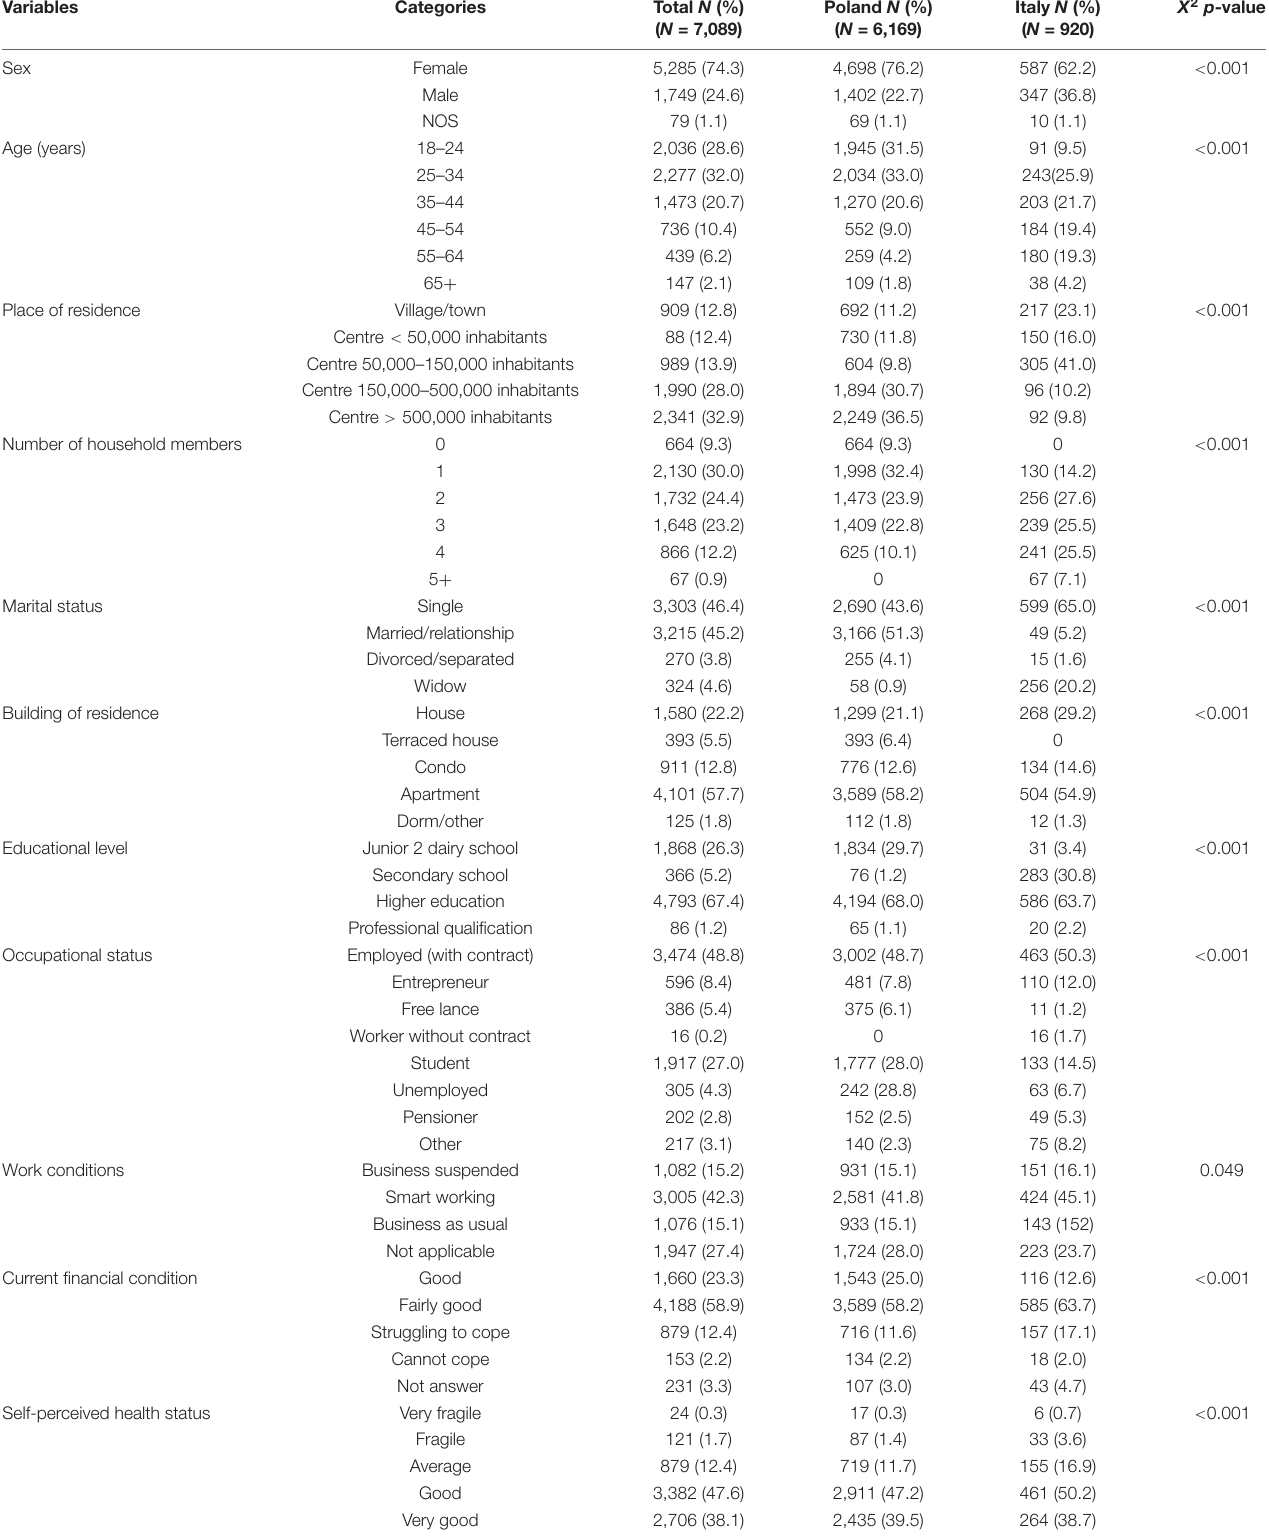
TABLE 1 | Distributions of socio-demographic information collected by the